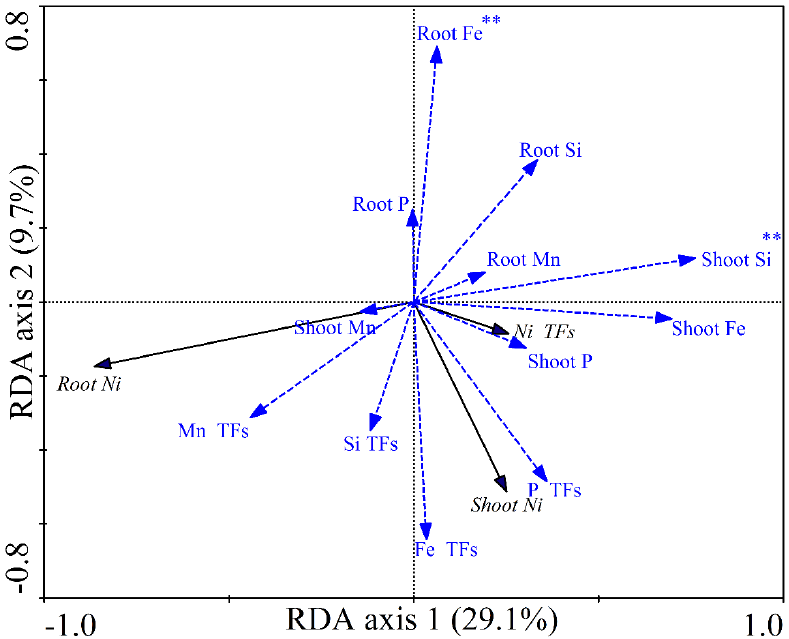
Figure 2. RDA (Redundancy analysis) ordination diagrams of the relationships between accumulation and translocation of Ni and multi-element concentrations in 72 rice cultivars. Shoot Ni, root Ni, and Ni TFs (translocation factors) are represented by black lines with arrows. Shoot Si, shoot P, shoot Fe, shoot Mn, root Si, root P, root Fe, root Mn, Si TFs, P TFs, Fe TFs, and Mn TFs are represented by blue lines with arrows. ** ( p < 0.01) represent significant factors influencing Ni accumulation and translocation based on Monte Carlo analysis (the number of permutations = 499).